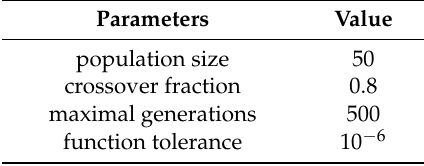
Table 5. Parameter setting of the genetic